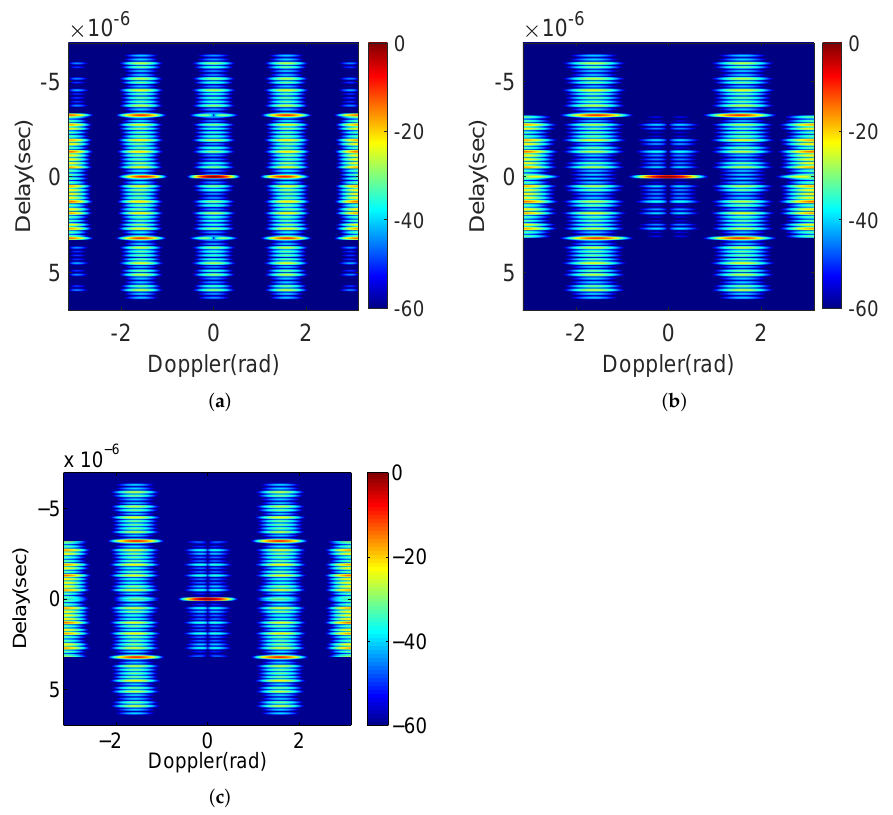
Figure A1. The ambiguity function of the GBD procedure using the example general complementary sets: ( a ) MBD algorithm; ( b ) SBD algorithm; ( c ) GBD procedure. (the unit of colorbar is dB).